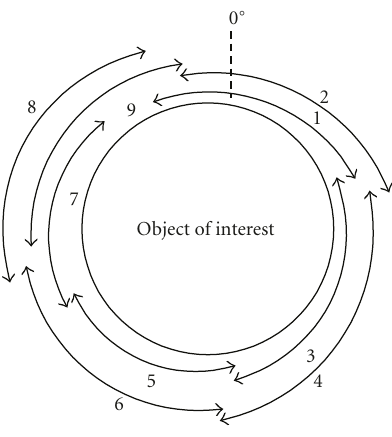
Figure 6: Example of non-existence of a mutually disjoint cover set with ρ min covers.